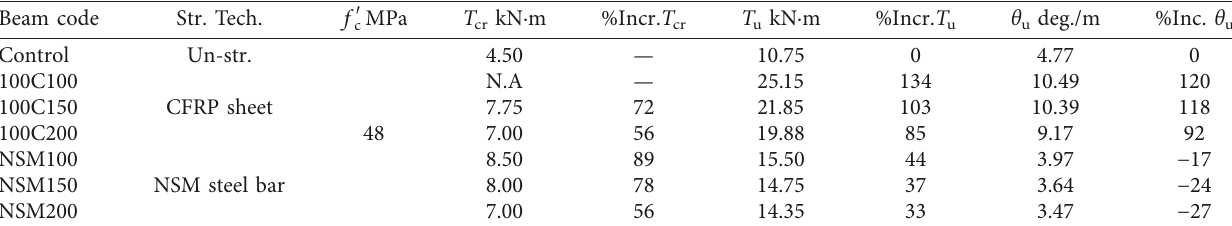
Figure 9: Angle of twist measurements. Table 6: Experimental results of the tested